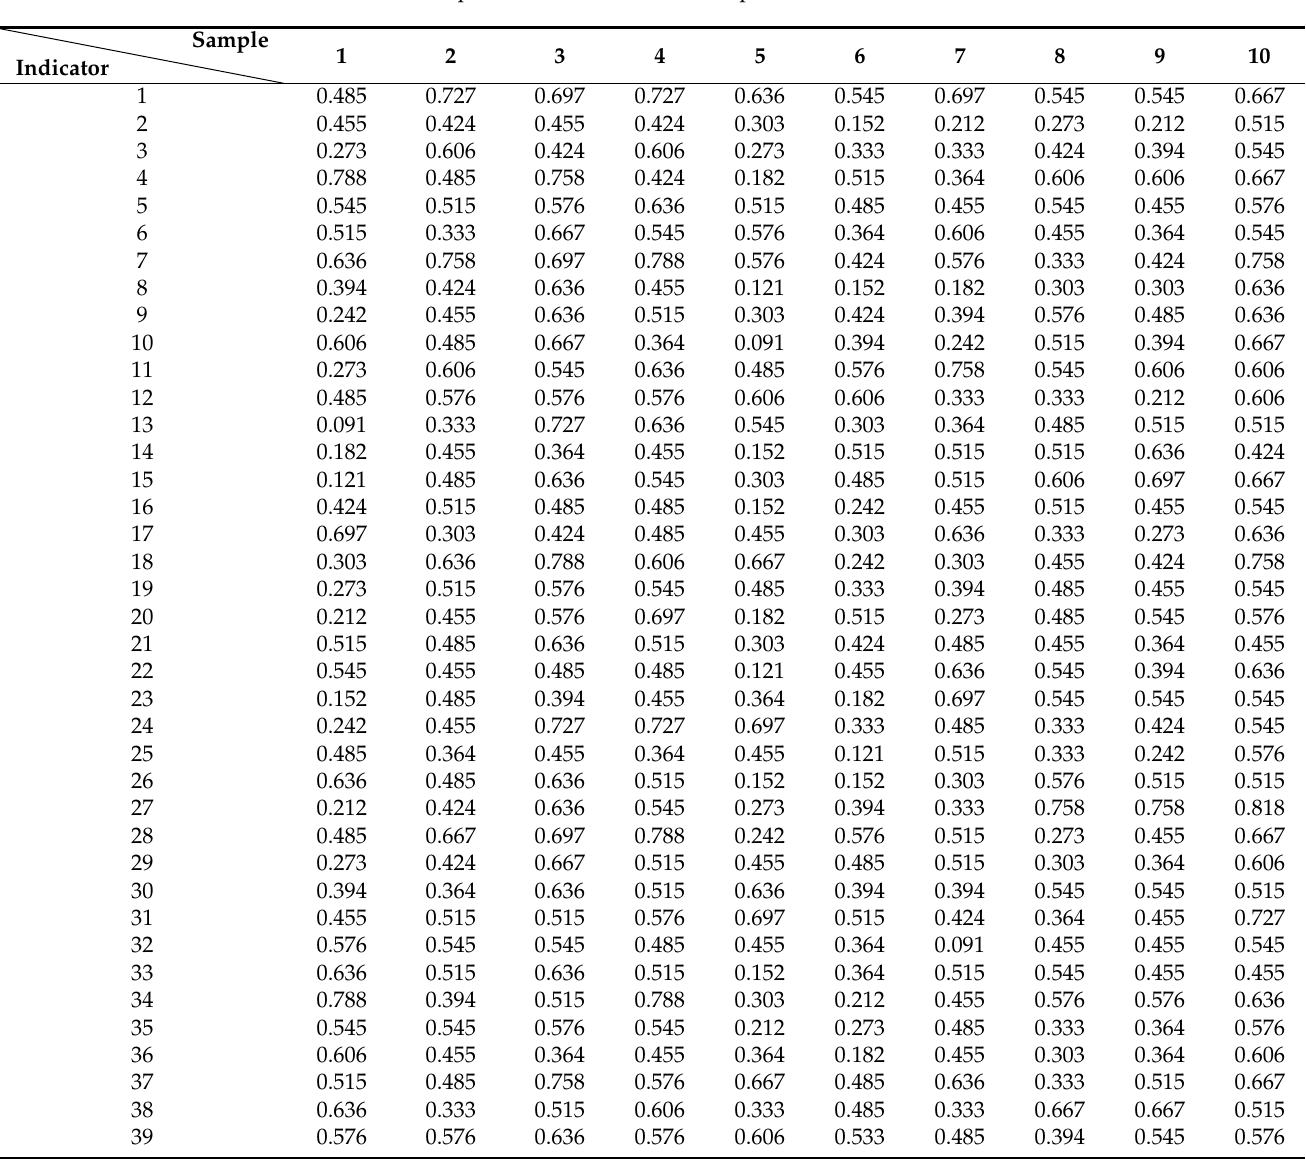
Table A16. Input data for the first ten